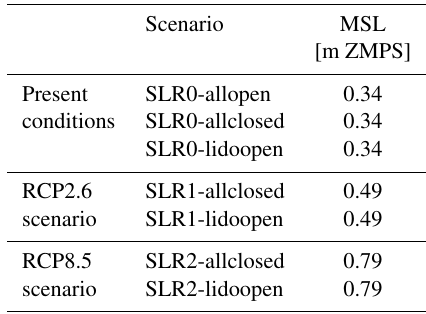
Table 1. Applied mean sea level (MSL) scenarios to assess future flood